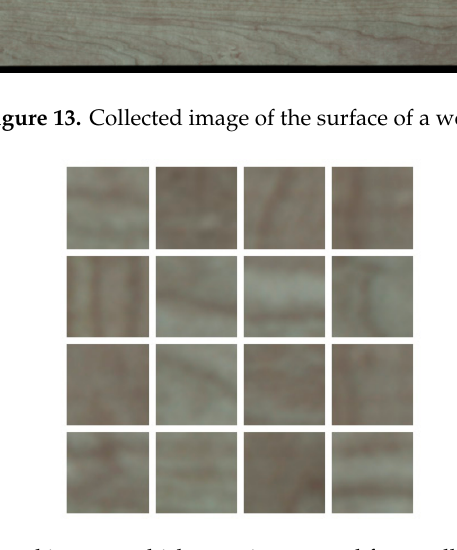
Figure 14. Some local images, which were intercepted from collected wood images.